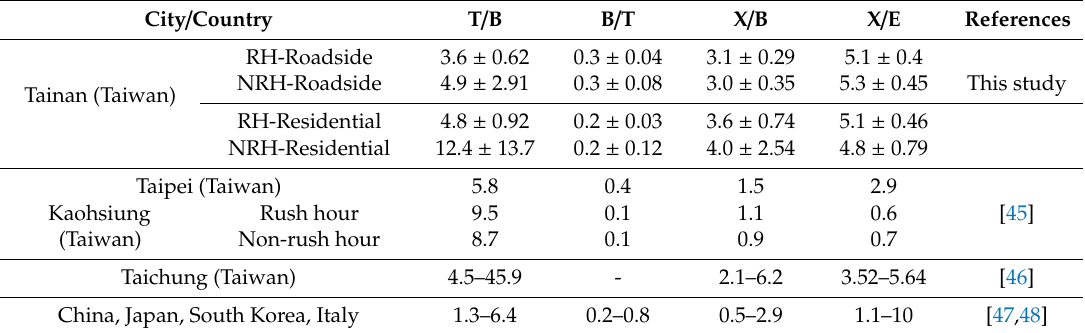
Table 3. Benzene, ethylbenzene, toluene and xylene (BTEX) concentration ratios. RH: Rush hours. NRH: Non-Rush